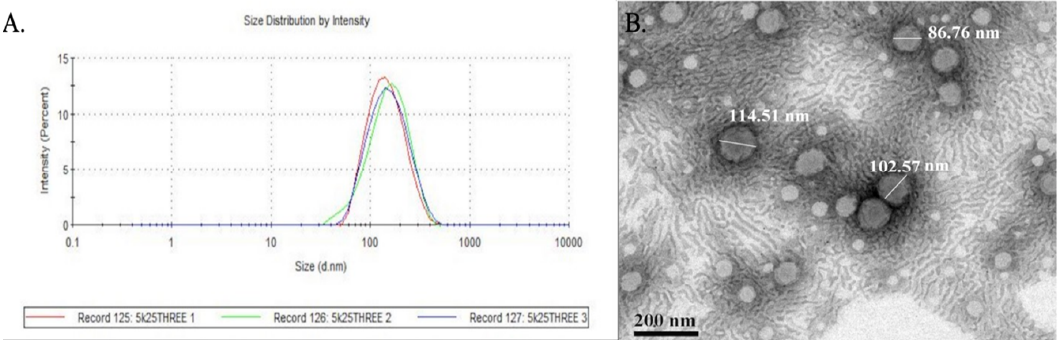
Figure 3. ( A ) Z-average of the SM-MPEG-PCL micelles and ( B ) 80,000 × TEM image of the SM-MPEG- PCL micelles at an accelerating voltage of 120 kV (scale bar 200 nm).